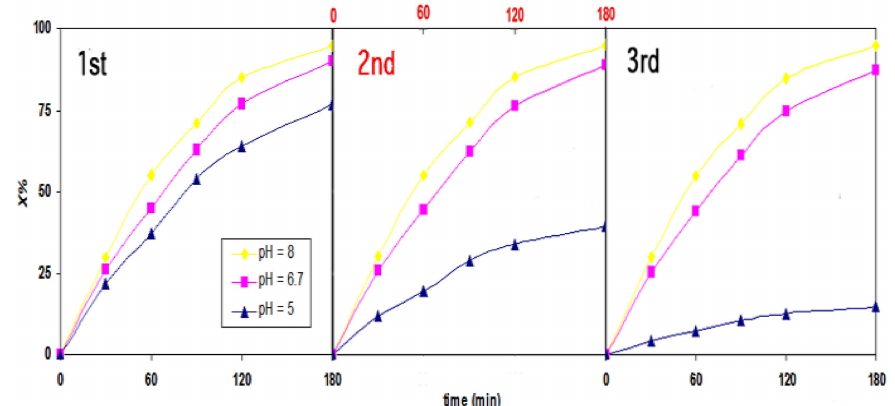
Figure 4. The photostability of ZnO nanoparticles based on an investigation of photocatalytic activity under UV illumination at pH values of 5, 6.7 and 8; [FB1] 0 = 50 mg / L) [ZnO] 0 = 1.2 g / L and T = 25 ◦